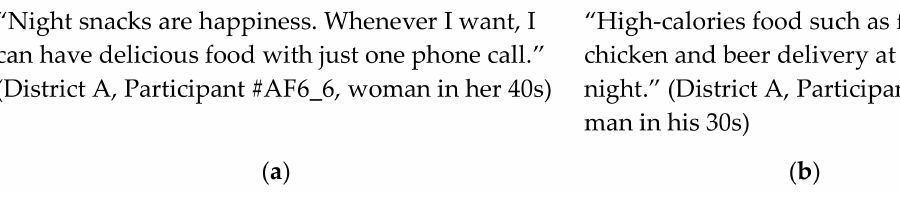
Figure 3. ( a ) Picture and statement depicting flyers and coupons for food delivery; ( b ) Picture and statement depicting a motorcycle delivering fried